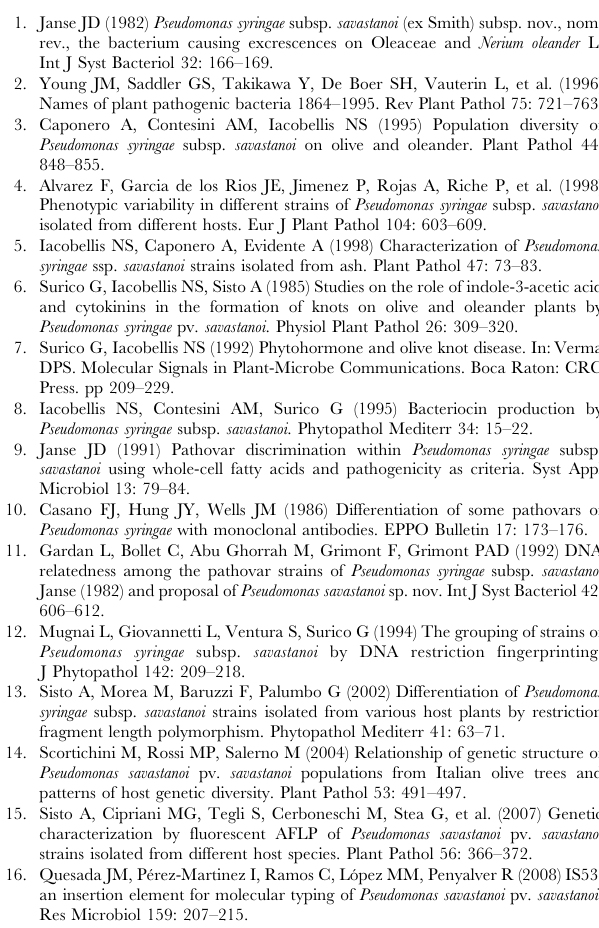
Relative fluorescence units. Green and red columns represent pre- and post-melting normalization regions. (TIF) Figure S5 HRMA multiplex assay on bacteria related to P. savastanoi . (A) Normalized melting curves obtained by using as template pure DNAs (10 pg/reaction) extracted from bacteria closely related to P. savastanoi (Table S1), and the primer pairs for SNP markers C2/L1. Pure DNAs from Psv5 , Psn23 and Psf134 were used as positive controls. Traces of different color indicate distinct HRMA profiles, produced by these bacteria and according to the color code reported in Table S1. No HRMA detectable signal was obtained for P. alcaliphila str. 28. and P. fluorescens str. 11. (B) Magnification of black-squared area in (A). (TIFF) Figure S6 Specificity of multiplex HRM assay for P. savastanoi pathovars detection tested against Oleander epiphytes. Normalized and difference HRM plots obtained by multiplex HRM assay performed with the combination of primer pairs for SNP markers C2/L1. Washings from Oleander leaves artificially surface-inoculated with Psv5, Psn23 and Psf134 were used for thermal lysis extraction of DNA, to be used as template. Bacterial suspension drops of 5 m l (upper plots) and 50 m l (lower plots) were spotted on each leaf side. Pure genomic DNAs from Psv5, Psn23 and Psf134 were also tested as controls. On each plot red, green and blue traces were produced by Psv5, Psn23 and Psf134 , respectively. RFU: